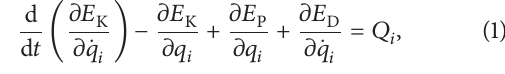
2.1. Equilibrium Equations of Motion. The dynamic